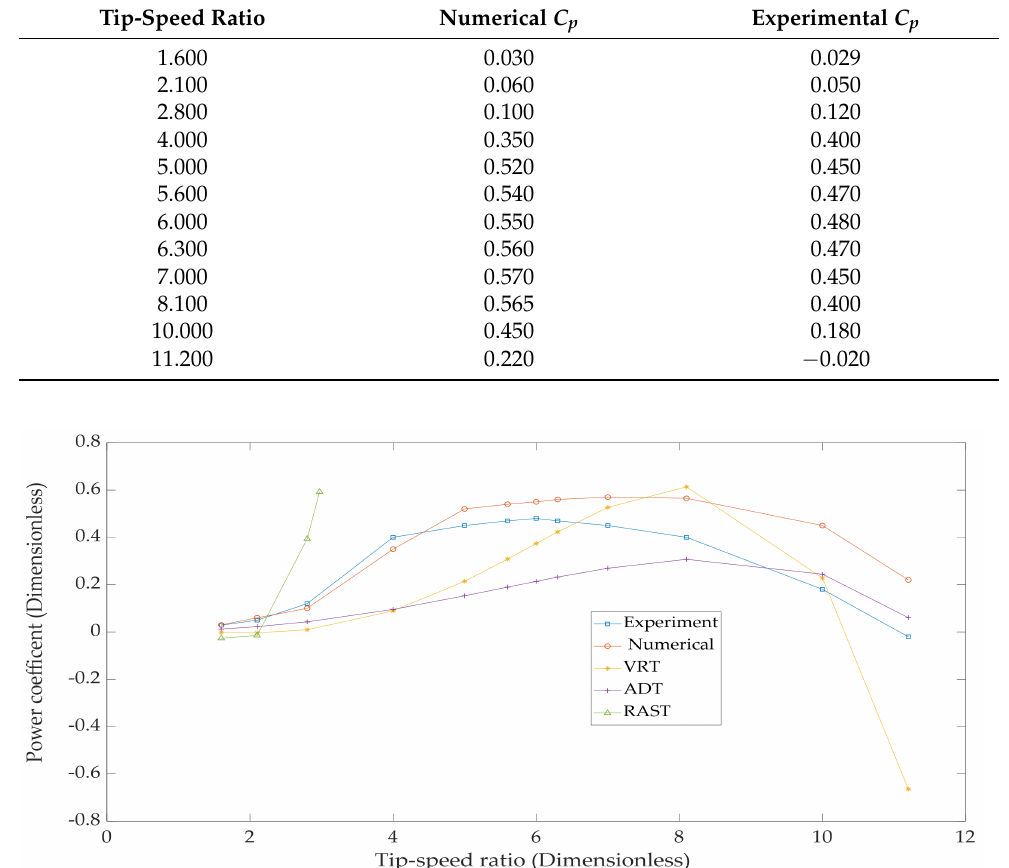
Figure 9. Power coefficient as a function of the tip-speed